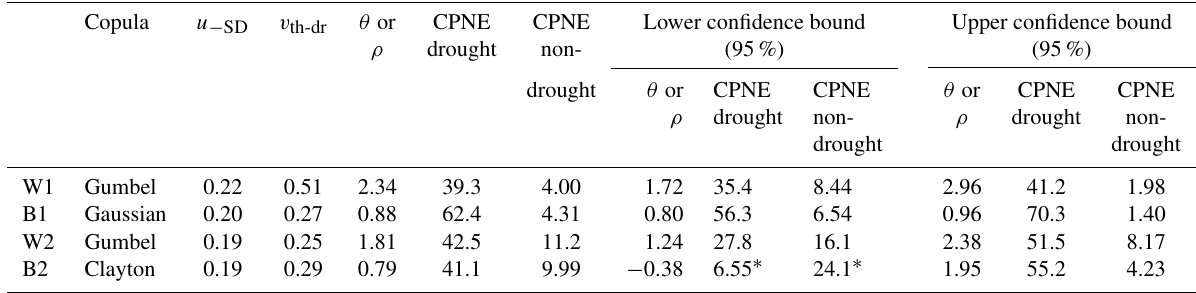
Table 4. Theoretical CPNE (%) during drought and non-drought conditions (Eqs. 9 and 10) and respective lower and upper bounds of the 95% confidence interval, where u − SD and v th-dr are the marginal probabilities of crop loss and drought occurrence and θ or ρ are the estimated copula parameters with 95% confidence limits (Table 3). The only exception that gives greater values of CPNE during non-drought conditions rather than drought is denoted by “ ∗